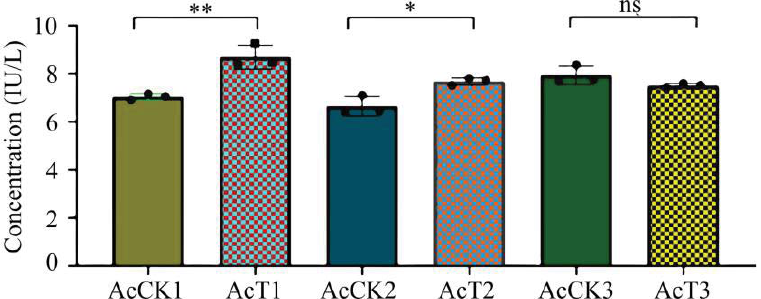
Figure 5. GST activity in A. cerana 4-, 5-, and 6-day-old larval guts infected by A. apis . The experi- mental data are shown as mean ± SD and were subjected to Student’s t -tests, ns: p > 0.05, *: p < 0.05, **: p < 0.01. AcCK1, AcCK2, and AcCK3 respectively represent the uninfected 4-, 5-, and 6-day-old larval guts, whereas AcT1, AcT2, and AcT3 respectively represent the A. apis –infected 4-, 5-, and 6-day-old larval guts.